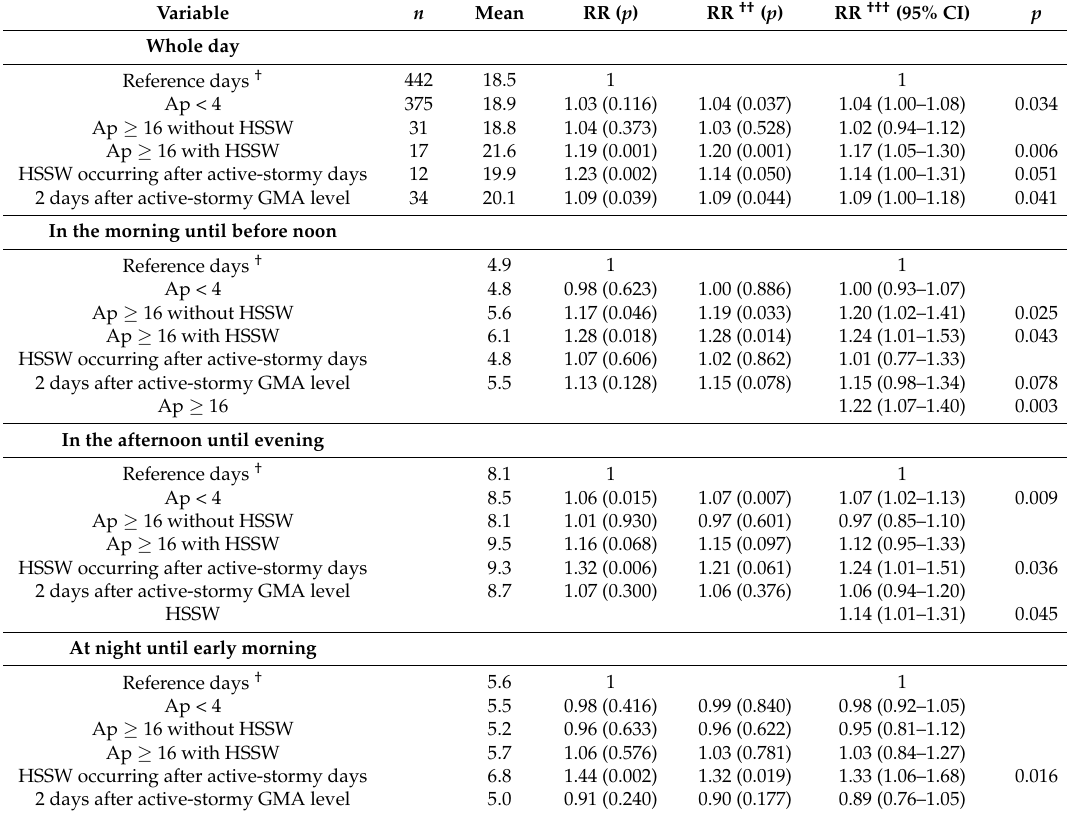
Table 4. Rate ratios with 95% confidence interval (CI) of emergency calls for EABP associated with space weather conditions; adjusting for day length, month, years, and the day of the week ( p > 0.5 not presented).